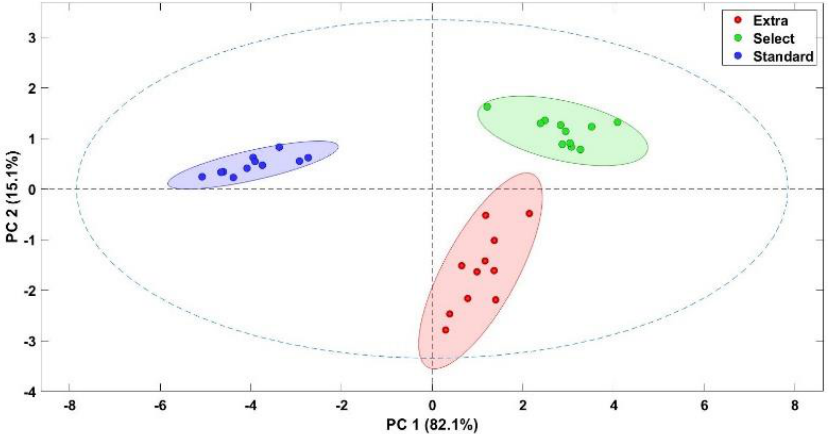
Figure 4. Score plot for the PCA analysis of Californian-style black olives stuffed with hydrocolloids.